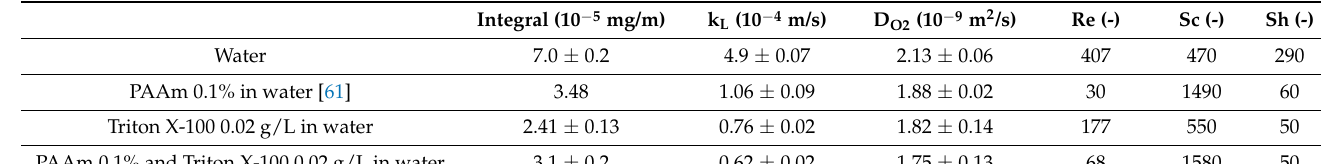
Table 2. Transfer parameters for different media.